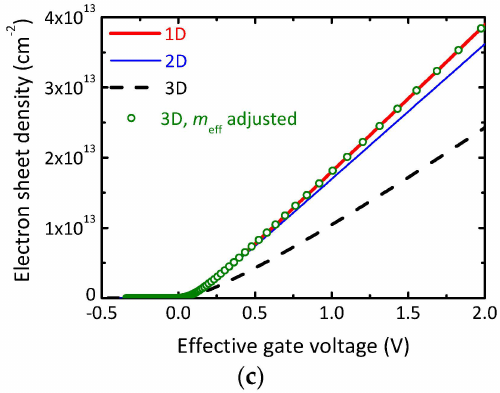
Figure 2. ( a ) Quantum capacitance of a N = 7 ac GNR (graphene nanoribbon) channel vs. Fermi level position assuming a 1D, 2D, and 3D density of states. ( b ) Quantum capacitance of the corresponding GNR MOS structure with 1 nm equivalent oxide thickness and a gate metal work function equal to the GNR electron affinity. ( c ) Electron sheet density of the GNR MOS structure from ( b ) vs. effective gate